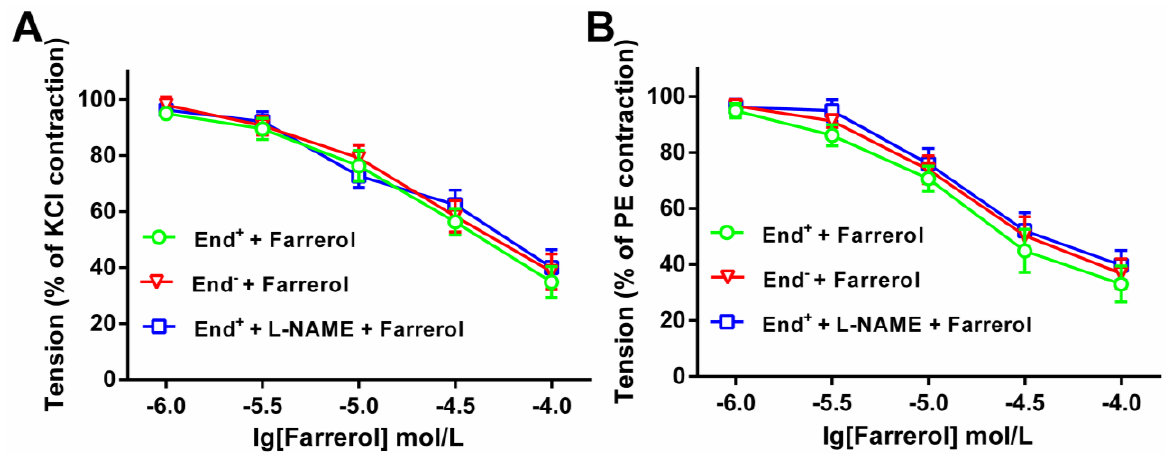
Figure 2. Farrerol-induced vasorelaxation in endothelium-intact (End + ) or -denuded (End − ) rat aorta rings precontracted with KCl ( A ) or phenylephrine (PE) ( B ). When the precontraction was sustained, L-NAME (0.1 mM) was added to the bath. When the contraction was steady again in the presence of the L-NAME, the concentration-relaxation curve of farrerol was reconstructed. Relaxations were expressed as percentages of the precontracton induced by 60 mM KCl or 1 µM PE, respectively. The statistical comparisons were made using one-way ANOVA followed by Newman-Keuls test. Data are expressed as means ± SD ( n = 7–8). * p < 0.05, vs . End + +